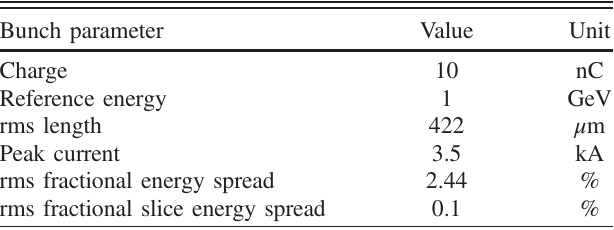
TABLE I. Main parameters associated with the drive bunch distribution shown in Fig. 2.